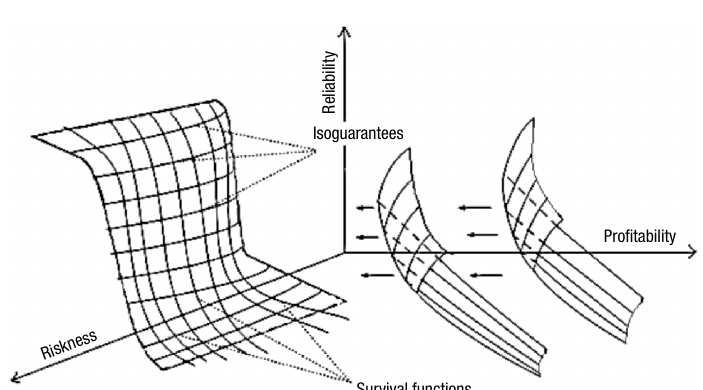
Fig. 4. Utility surface approaching the surface of possibilities (Rutkauskas